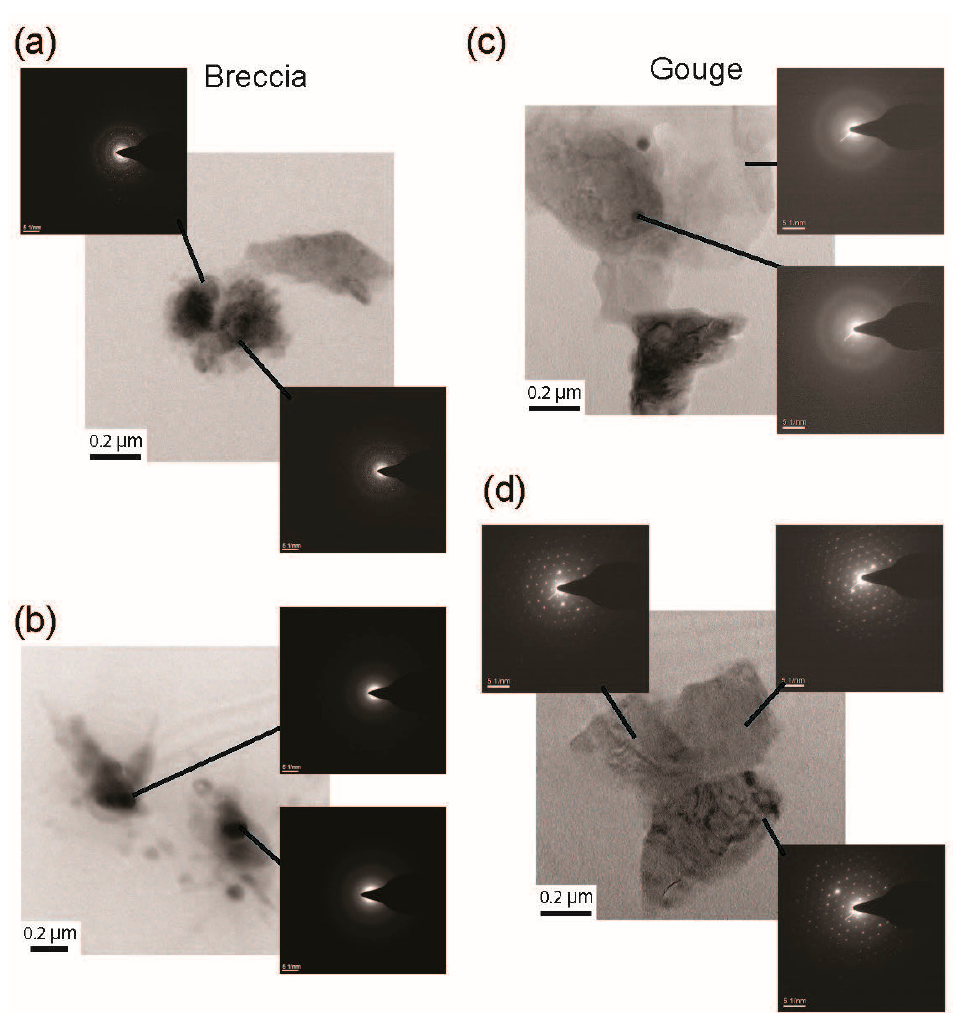
Figure 4. Microstructures of carbonaceous materials of both breccia (at the depth of 588.70 m) and gouge (at the depth of 589.23 m). ( a , b ) Poorly ordered carbon grains (see selected-area electron diffraction (SAED) patterns) within the breccia samples (transmission electron microscope (TEM) images). ( c , d ) poorly ordered to well crystallized carbon grains (see SAED patterns) within the gouge samples (TEM images).